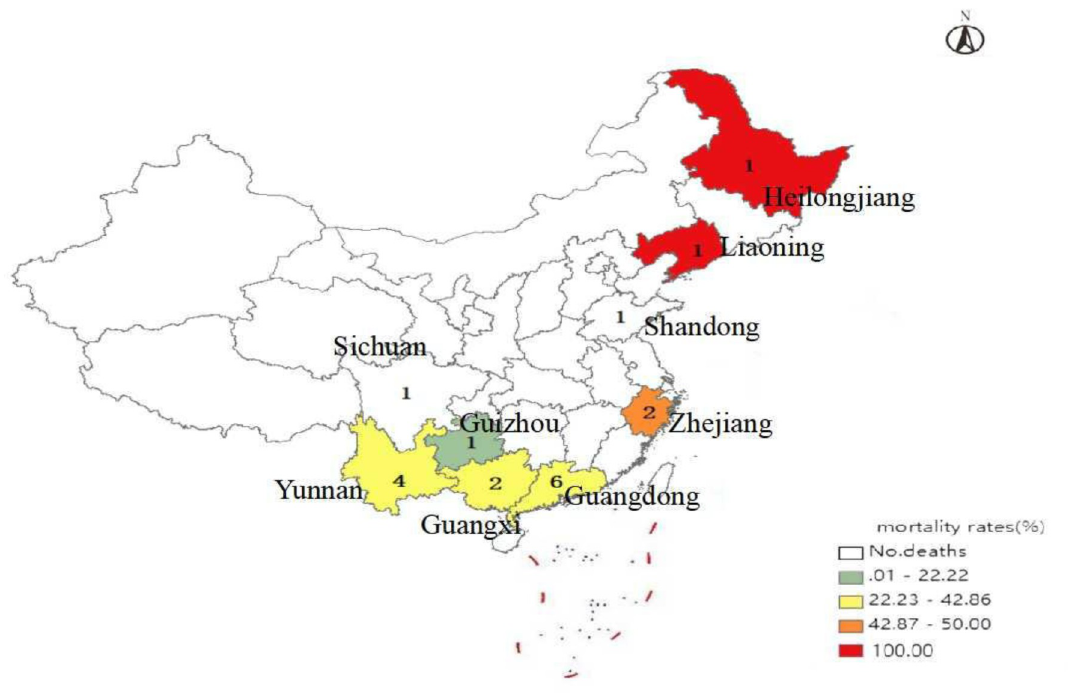
Fig 2. Total number and mortality rate of reported bongkrekic acid poisoning outbreaks by province, China, 2010–2020. Number given in each province indicates the total number of outbreaks; color boxes indicate the mortality rate.